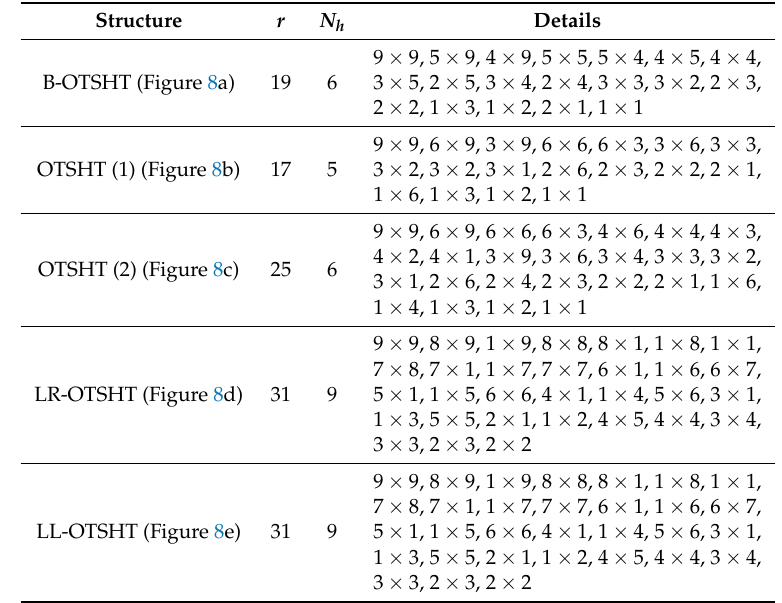
Table 2. Number of rectangles of different sizes having different heights of 9 × 9 OTSHT.